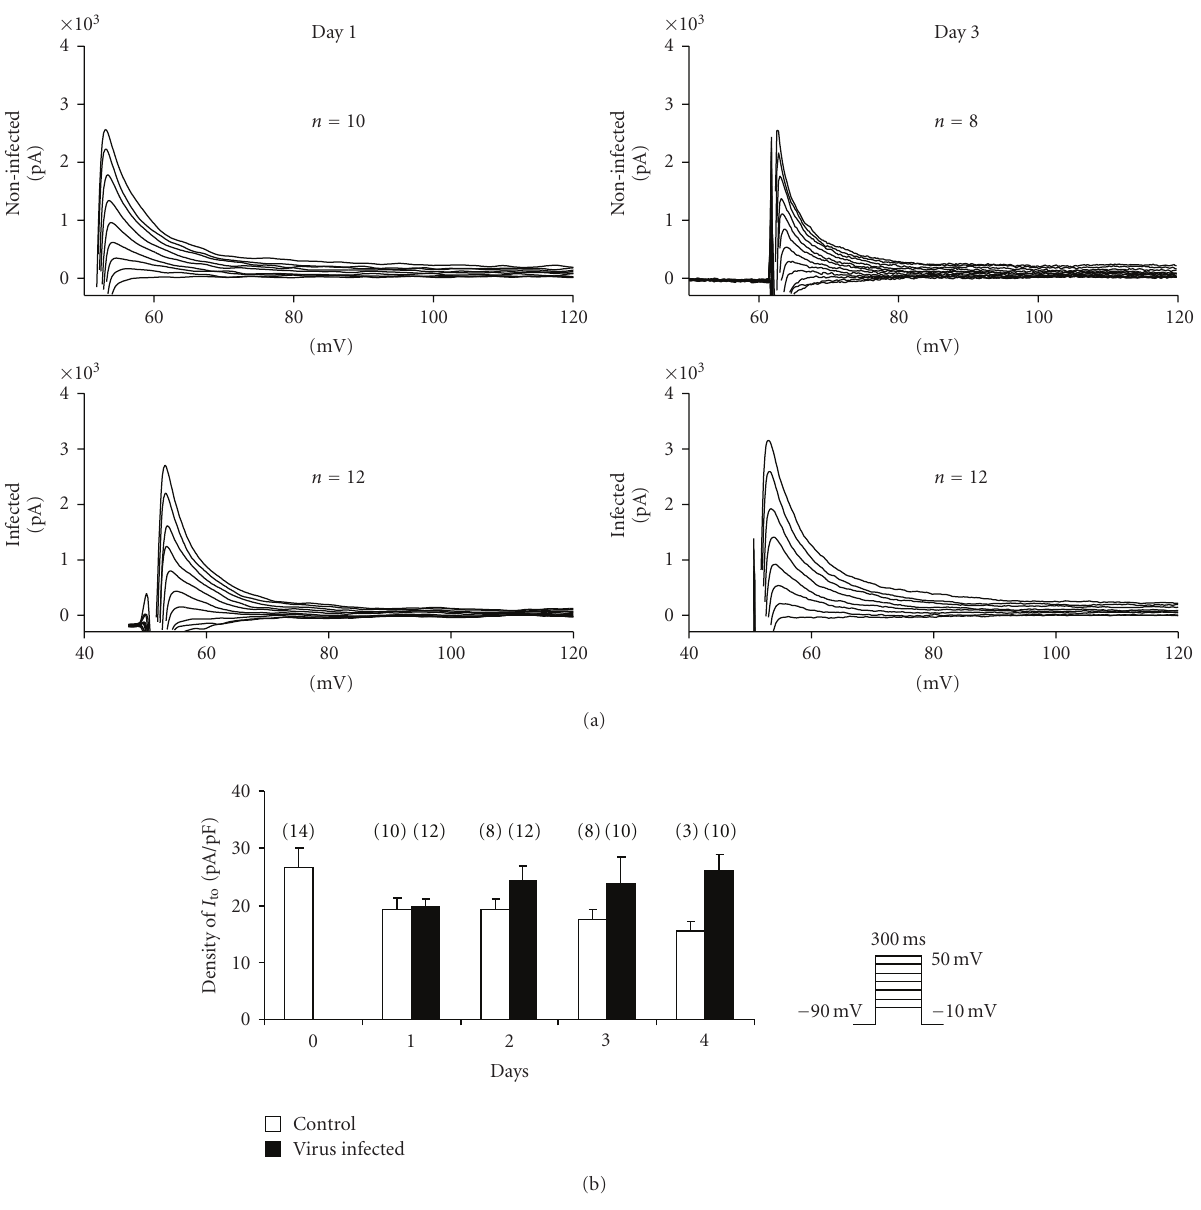
Figure 4: (a) Transient outward K current (I to ) recordings from control and from virus-infected myocytes after (a) 1 and (b) 3 days of culture. Inset shows applied voltage protocol. (b) shows the I to current densities from control and from virus-infected myocytes after 1 to 4 days long culture. Data represent means ± SEM, and n represents the number of